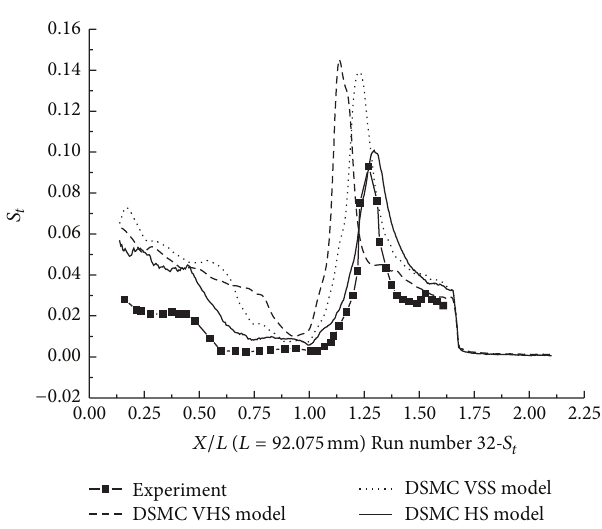
Figure 19: DSMC simulation of Run number 32 ( 𝑆 𝑡 ).